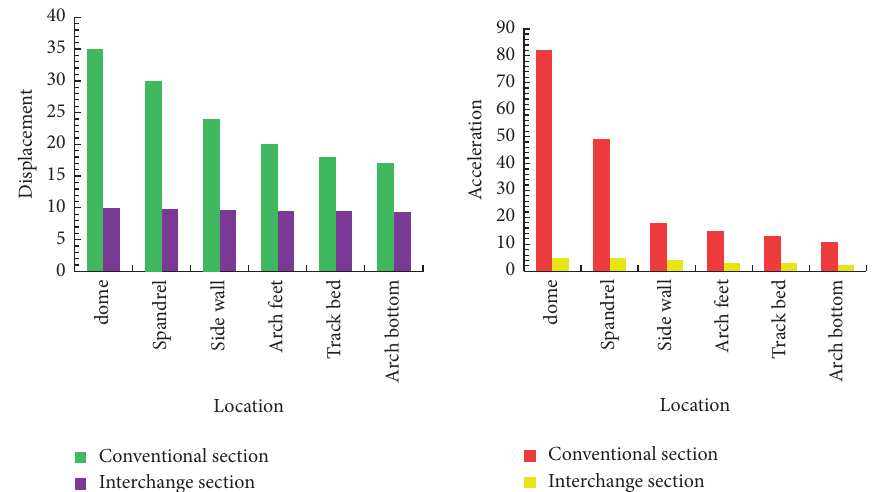
Figure 9: Vertical displacement changes and acceleration peak trends of each observation